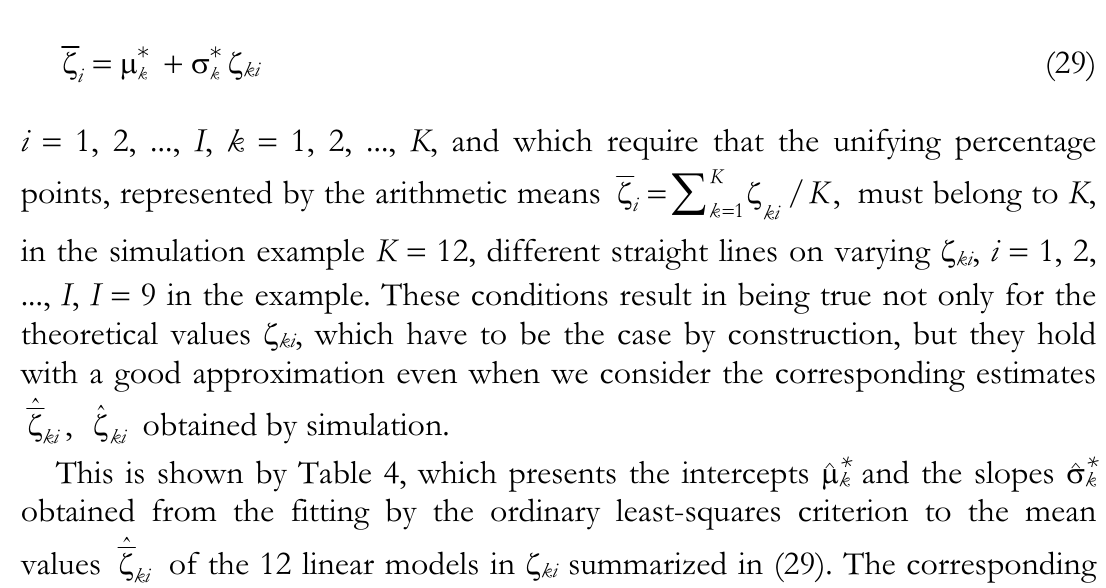
Ordinary least-squares estimates of the slopes and intercepts of the 12 straight lines (29) to which the percentage points arithmetic means ˆ